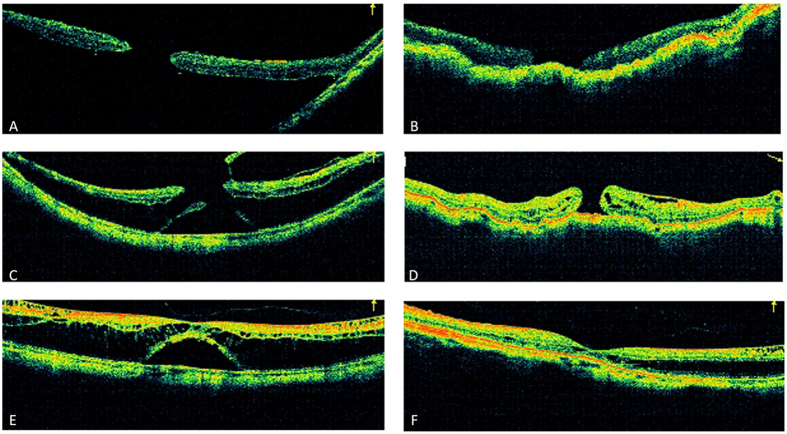
(A) For eye No. 8, preoperatively, OCT images showed a huge macular hole and associated retinal detachment. The logMAR best-corrected visual acuity was 2.0. The axial length was 30.0 mm. (B) After posterior scleral contraction (PSC), there was a complete retinal reattachment, but the macular hole was not closed. The logMAR best-corrected visual acuity was 1.4. The axial length was 26.63 mm. (C) For eye No. 26, preoperatively, OCT images showed a macular hole and associated retinal detachment, and the epiretinal membrane was present as well. The logMAR best-corrected visual acuity was 0.52. The axial length was 30.49 mm. (D) After PSC, the macular hole was not closed, and the retinal detachment area was reduced by more than 80% but not completely. The retinal detachment was still present around the macular hole edge, which was defined as essential reattachment. The logMAR best-corrected visual acuity was 0.4. The axial length was 27.88 mm. (E) For eye No. 31, preoperatively, OCT images showed foveal detachment and myopic foveoschisis. The logMAR best-corrected visual acuity was 0.52. The axial length was 27.98 mm. (F) After PSR, the retinal detachment area was reduced by 40%~79%, and retinal detachment was still present, which was defined as partial reattachment. The logMAR best-corrected visual acuity was 0.22. The axial length was 26.87 mm.